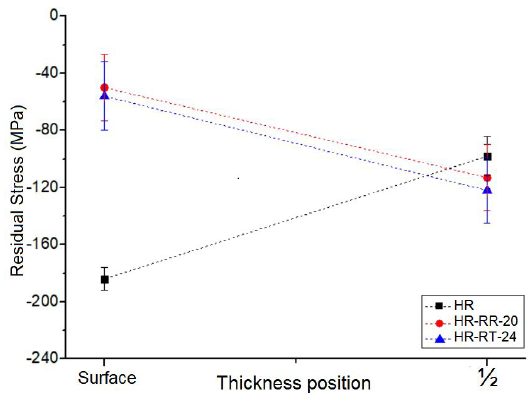
Figure 7. Comparison of residual stresses of the austenite phase among HR samples in as-received condition and after rolling and tensile test at room